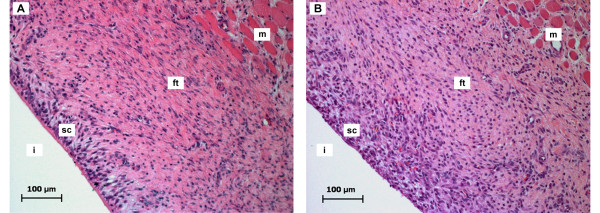
Image sections of cranial tibial muscle cross sections two weeks post operatively (H. E., 200×). (A) MgCa0.8 implant site and (B) S316L implant site, respectively. Note the fibrous tissue (ft) that formed between the cranial tibial muscle (m) and the implant site (i) and is surrounded by a layer of synoviocyte-like cells (sc) at its interface to the implant in both implant materials.